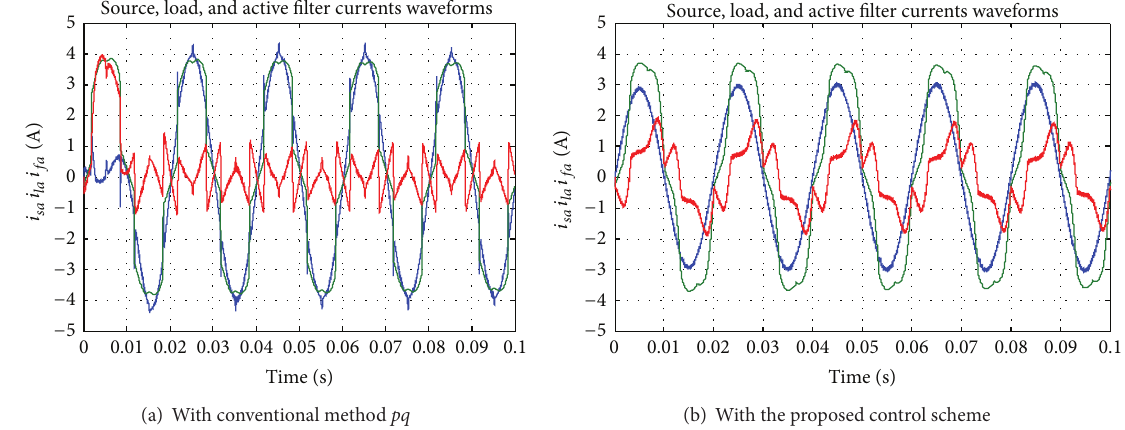
Figure 16: Source, load, and active filter currents of phase- a waveforms.